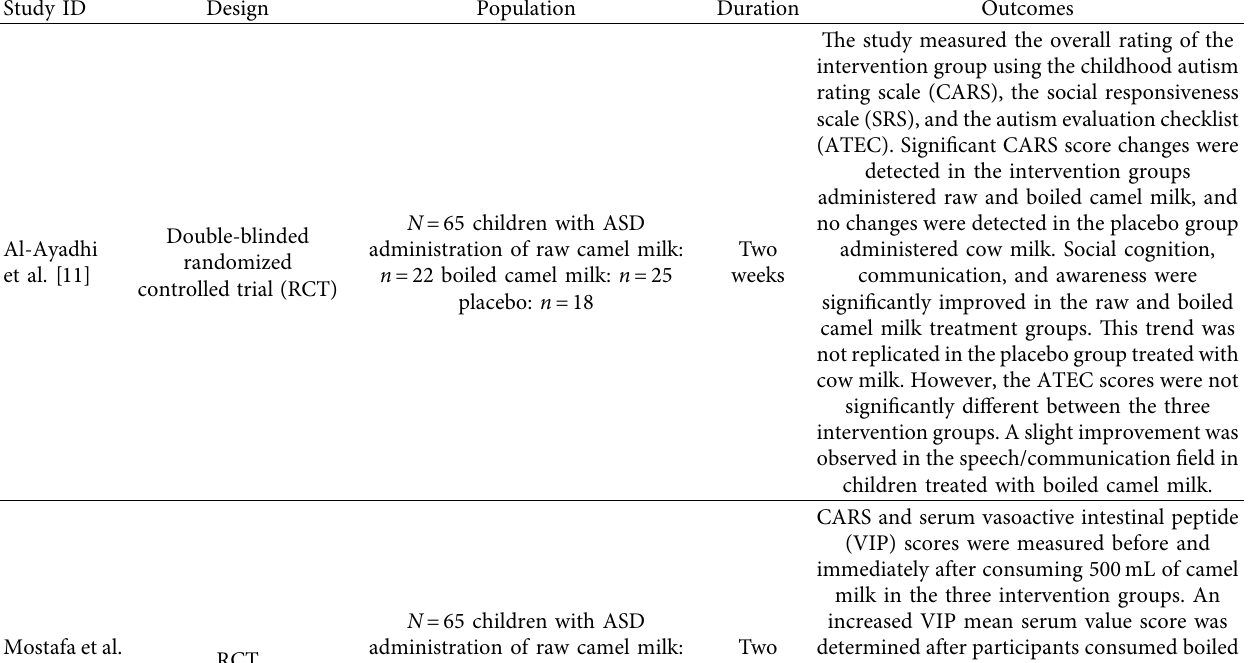
Table 1: Characteristics of studies included in the meta-analysis of the effects of camel milk consumption on CNS symptoms. Study ID